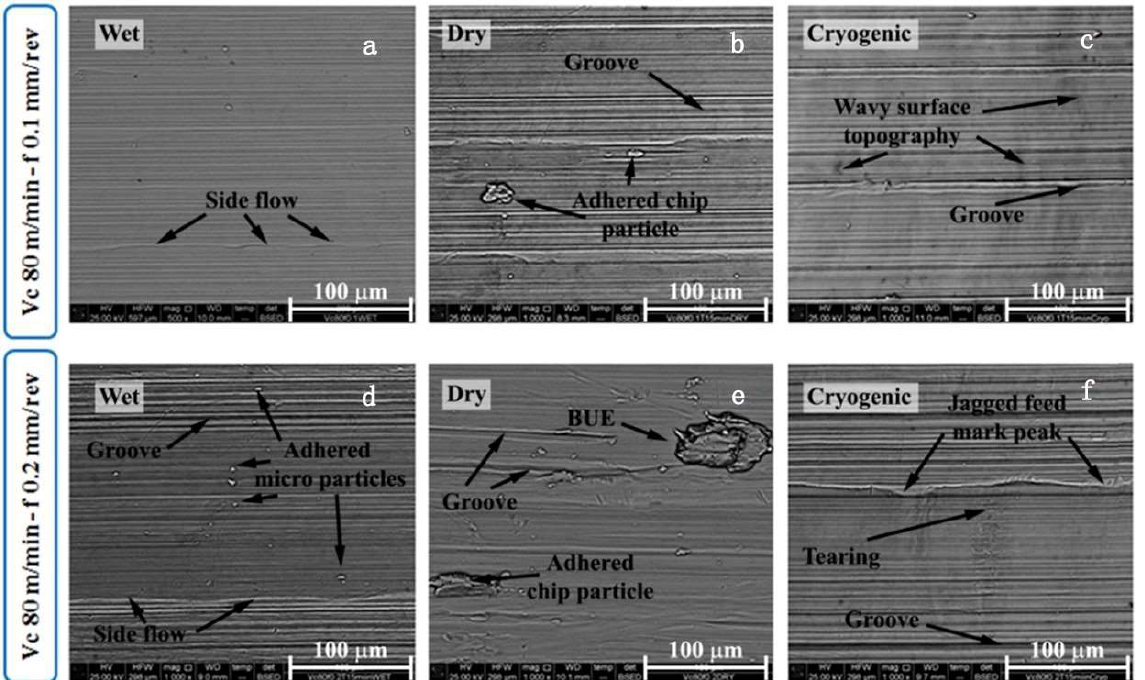
Figure 4. Main surface defects after 8 min of turning when adopting the wet, dry, and cryogenic cooling strategies: ( a , d ) material side flow, double feed marks, long grooves, and micro-particles adhered on the machined surface; ( b , e ) wider adhered chip fragments and BUE are attached to the machined surfaces; ( c , f ) the wavy surface topography along the cutting speed direction and the jagged feed mark peak [107] (Reprinted with permission from [107]. Copyright 2017, Elsevier).